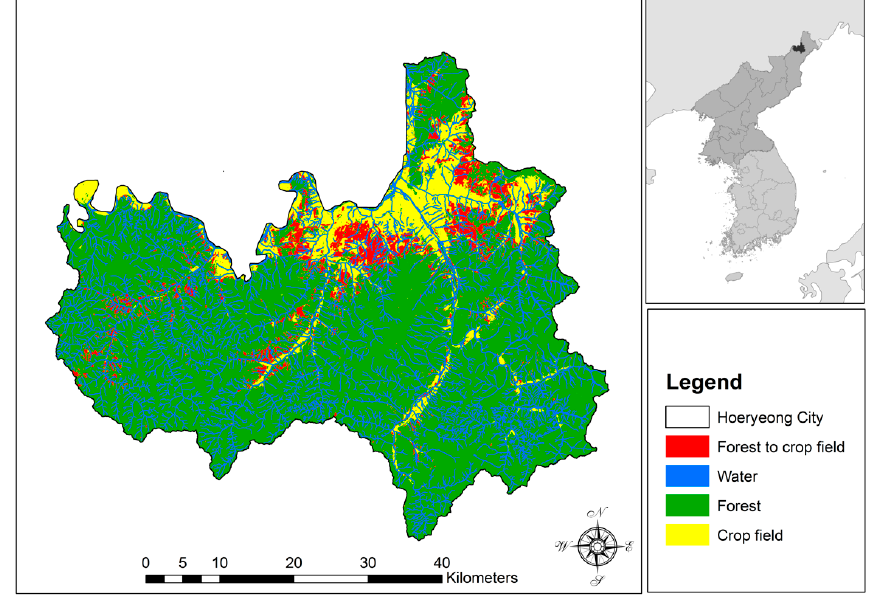
Figure 4. Map of land-use change (i.e., forest to crop field) within the study